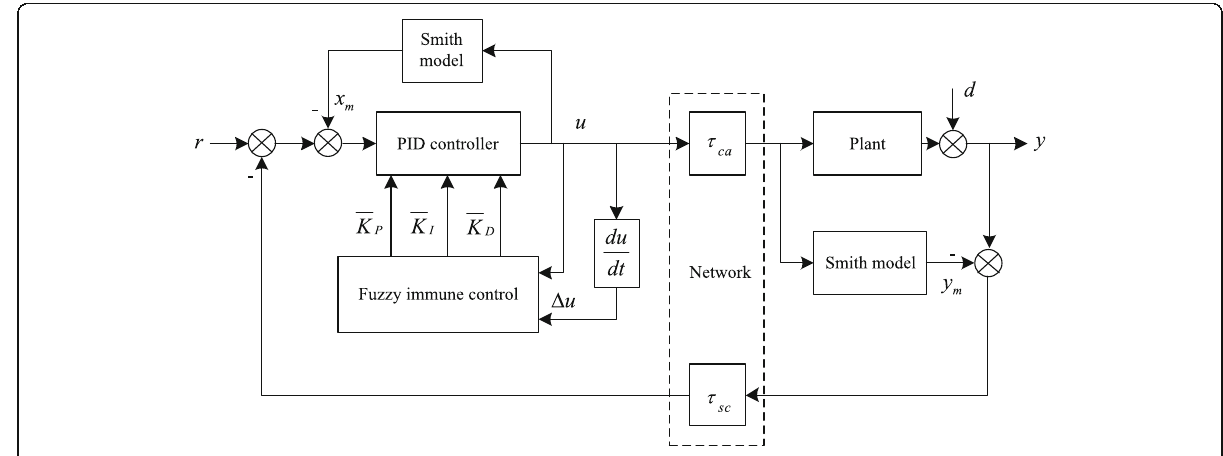
Fig. 6 The new Smith predictor and improved fuzzy immune PID